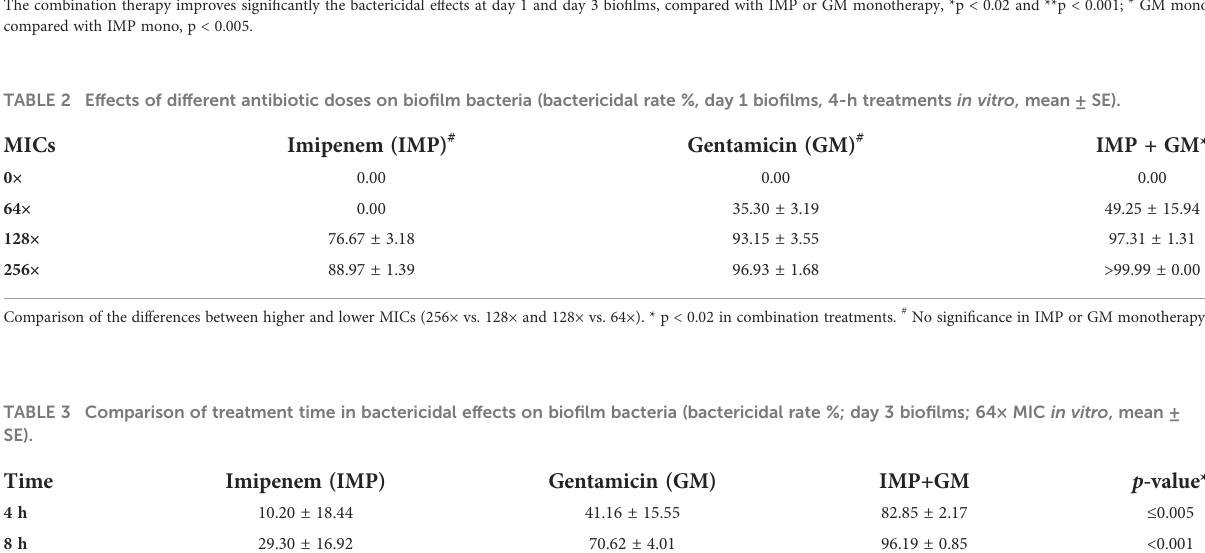
TABLE 3 Comparison of treatment time in bactericidal effects on bio fi lm bacteria (bactericidal rate %; day 3 bio fi lms; 64× MIC in vitro , mean ± SE). Time 4 h p -value # *Combination therapy vs. IMP or GM monotherapy. # 8-h vs. 4-h treatments. n.s., no signi fi cance.